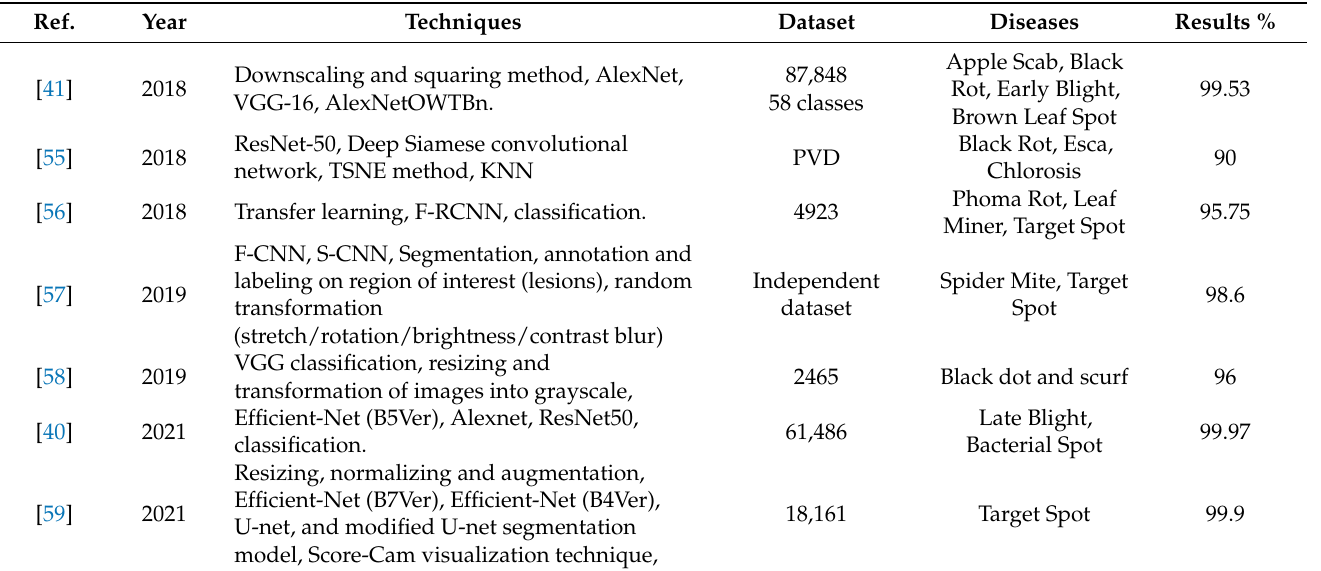
Table 1. An overview of recent literature regarding plants diseases